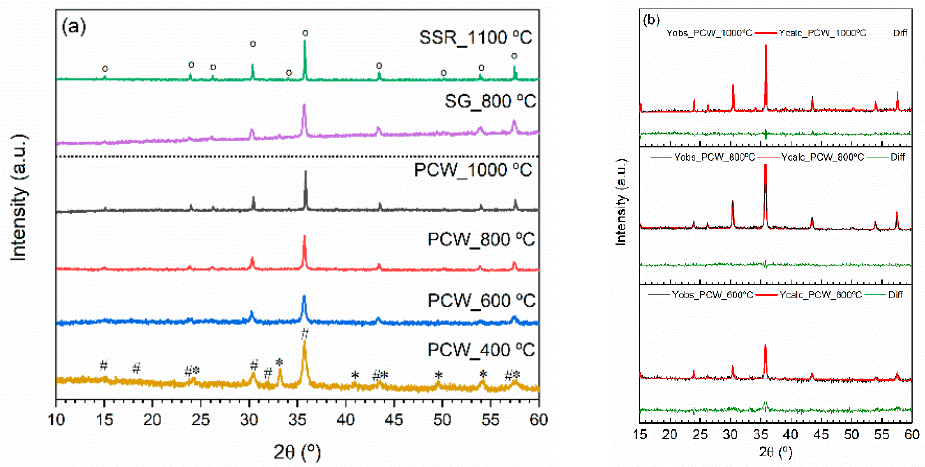
Figure 2. ( a ) XRD diffractograms of the samples heat-treated between 400 and 1000 ◦ C and of the samples prepared by sol-gel (SG_800 ◦ C) and by solid-state reaction (SSR_1100 ◦ C) [48] (o LiFe 5 O 8 ; * Fe 2 O 3 ; # Fe 2 . 67 O 4 ); ( b ) Rietveld refinement of the samples treated at 600, 800 and 1000 ◦ C, showing the experimental data, Y obs , the refinement adjust, Y calc , and the difference between them, Diff.